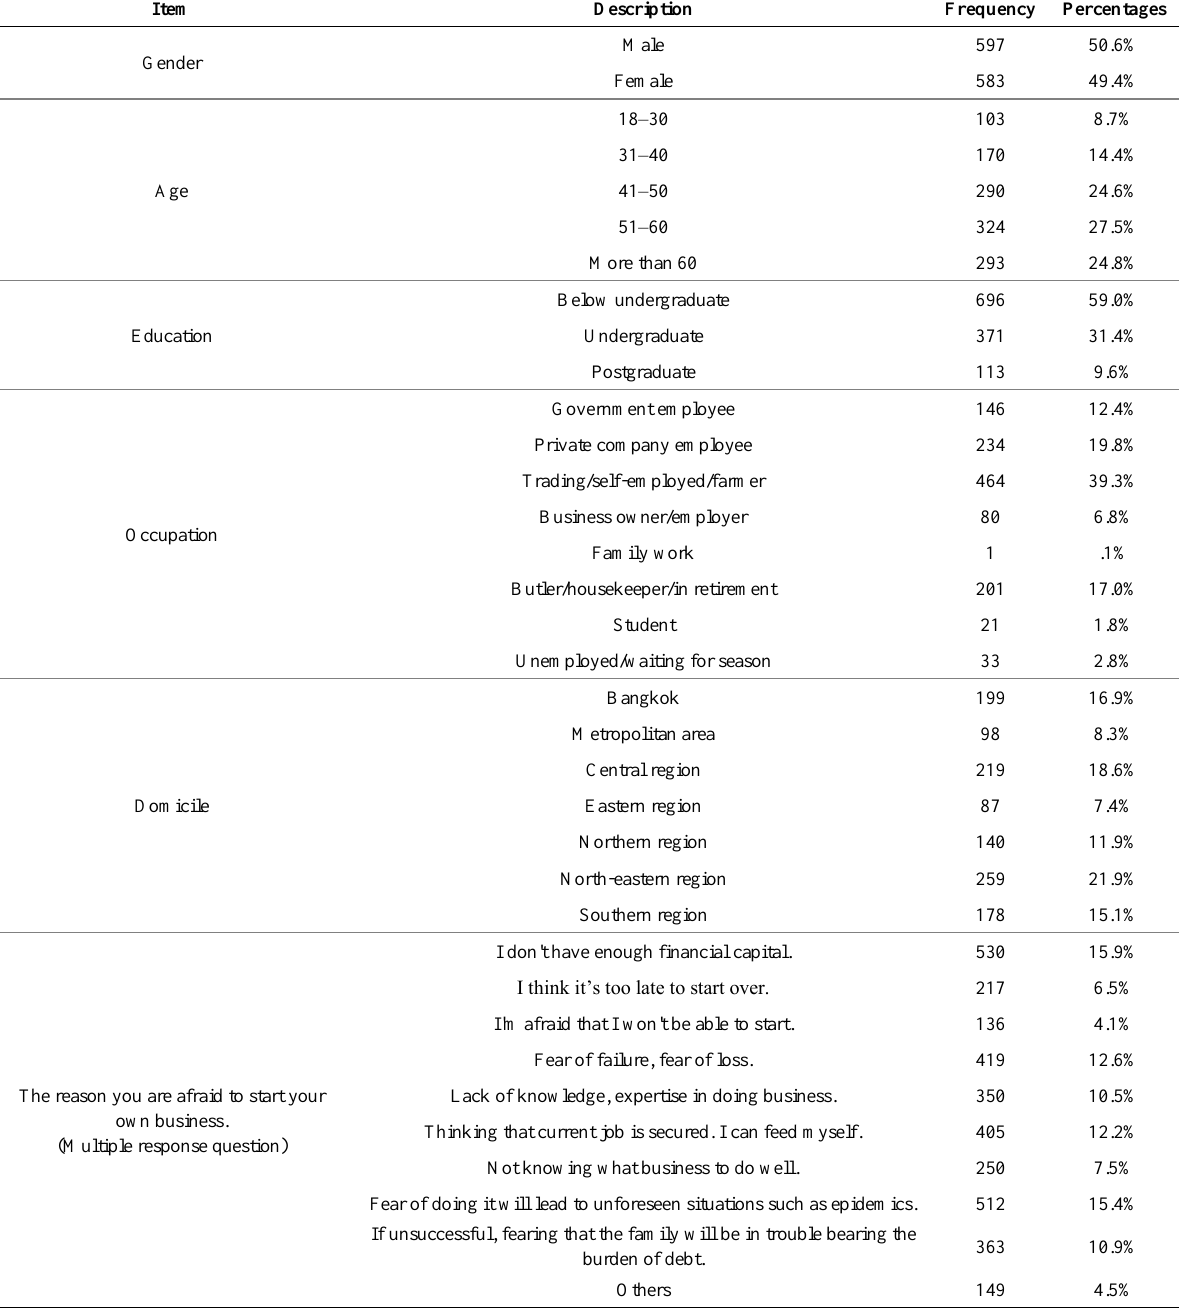
Table 2. Demographic Profiles of the Sample